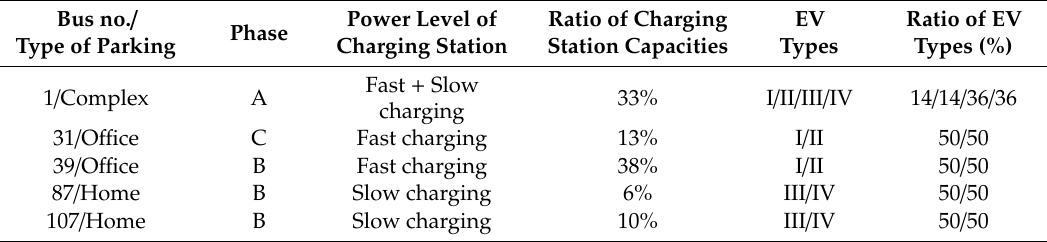
Table 2. Optimal configuration of EV charging